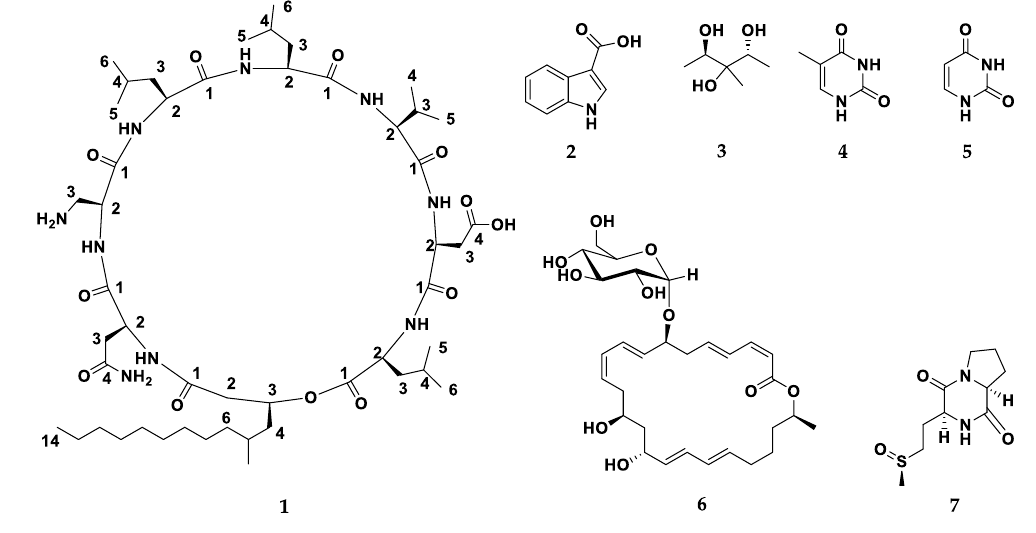
Figure 1. Structure of compounds 1 – 7 .